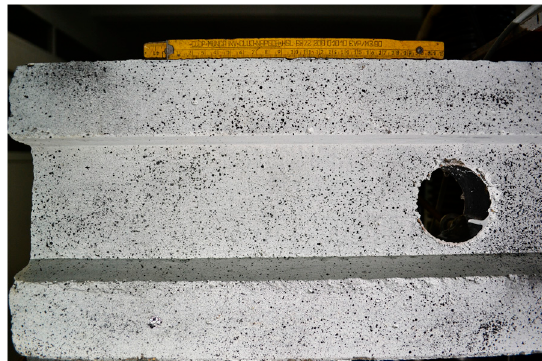
Figure 4. Speckle pattern on the surface of the analyzed area.